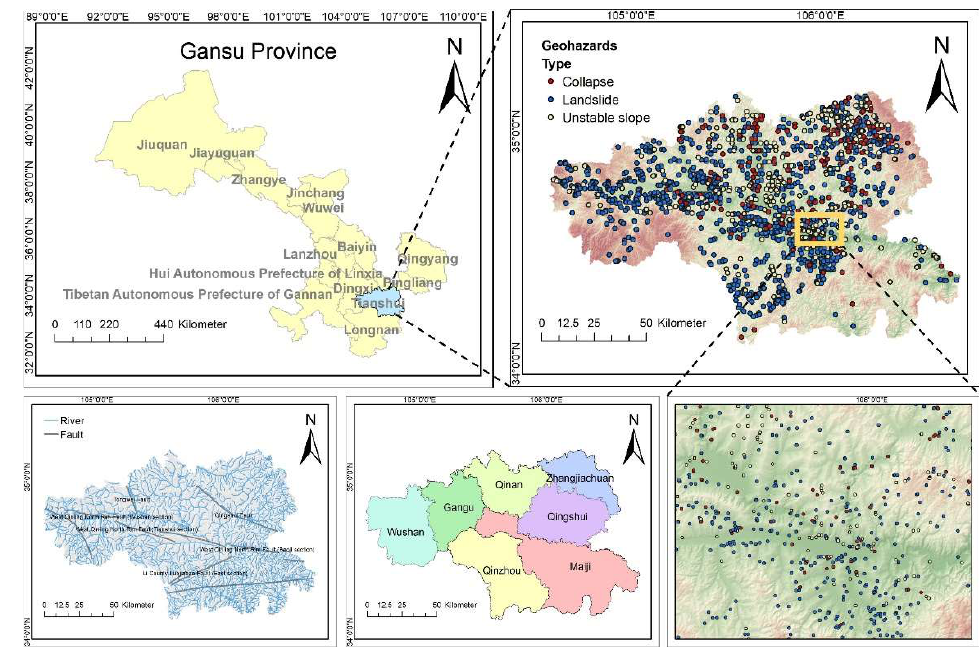
Figure 2. Location and geohazard distributions of Tianshui city. Table 1. Raw data resources for feature extractions and geohazard inventories, the obtaining resources (platforms or websites) are listed as